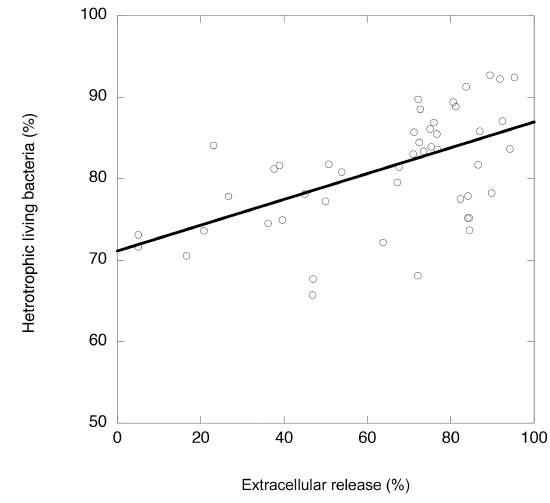
Figure 7. The relationship between the percentage of living het- erotrophic bacteria and the percentage of extracellular dissolved organic carbon release. The open symbols represent the individual percentage of living bacteria and the full line represents the fitted re- gression equation between the percentage living heterotrophic bac- teria and PER (%LC = 71 . 6 + 0 . 16PER; P < 0 . 0001, R 2 = 0 . 35). cell level (Agustí and Sánchez, 2002; Bidle and Falkowki, 2004; Gasol et al., 2008; Lasternas et al., 2010) to resolve and that of heterotrophic bacteria, mediated by the extracel- lular release of organic